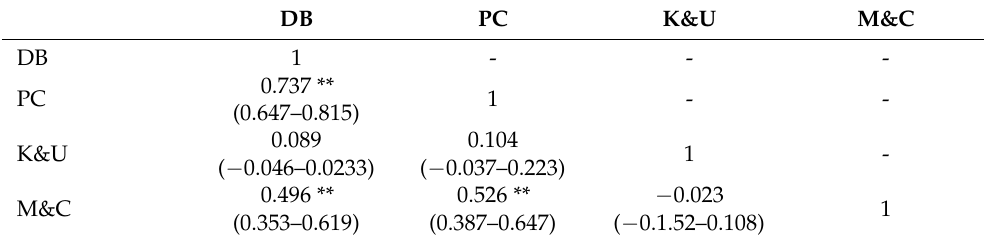
Table 4. Correlations between physical literacy domain scores in overweight and obese children.